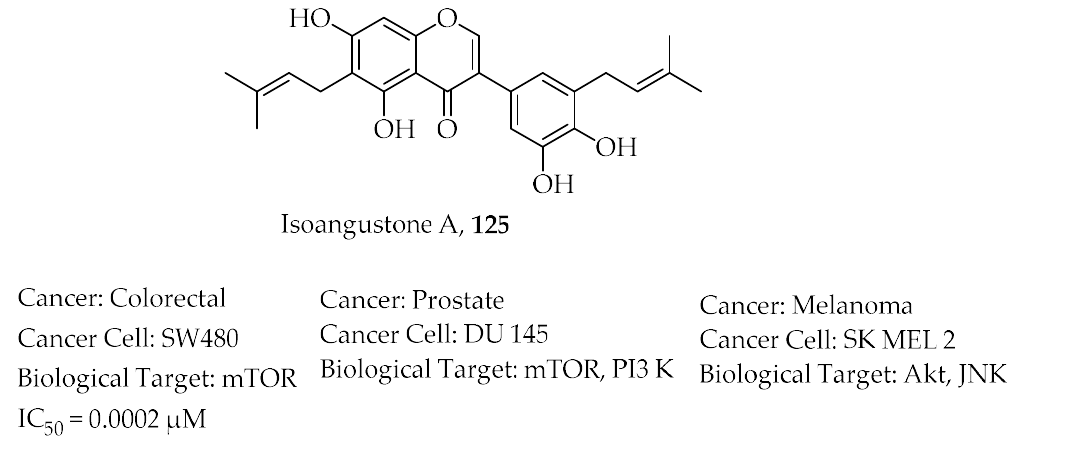
Figure 20. Structure of the dihydroxyflovanone Liquiritigenin with a summary of its biological ac- tivity towards selected cancer targets.